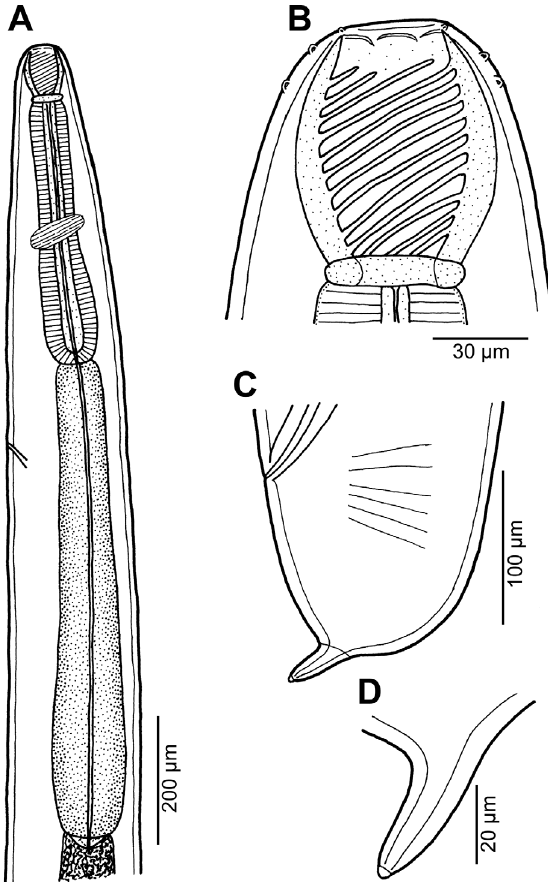
Figure 13. Procamallanus ( Spirocamallanus ) sp. 2 from Stegos- toma fasciatum , subgravid female. (A) Anterior end, lateral view; (B) buccal capsule, lateral view; (C) tail, lateral view; (D) tail tip, lateral